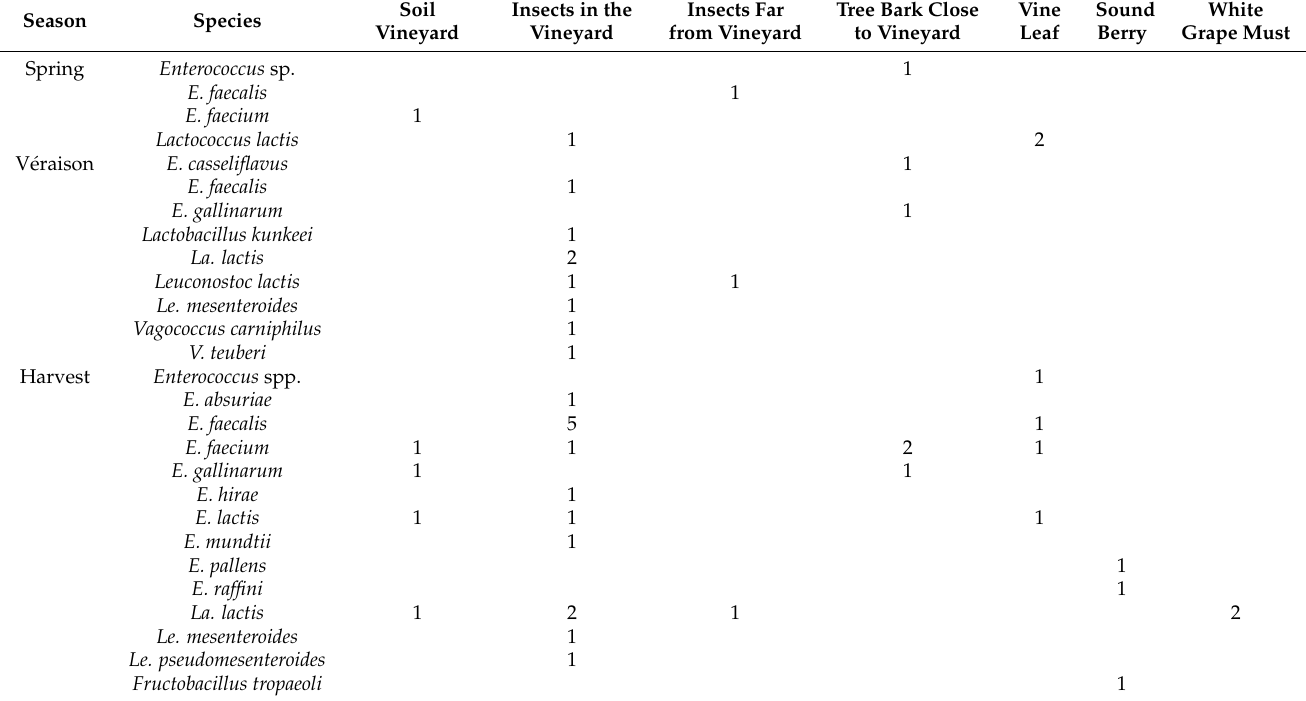
Table 5. Number of samples from environmental and winery samples harboring lactic acid bacteria. Soil Insects in the Insects Far Tree Bark Close Vineyard Vineyard from Vineyard to Vineyard